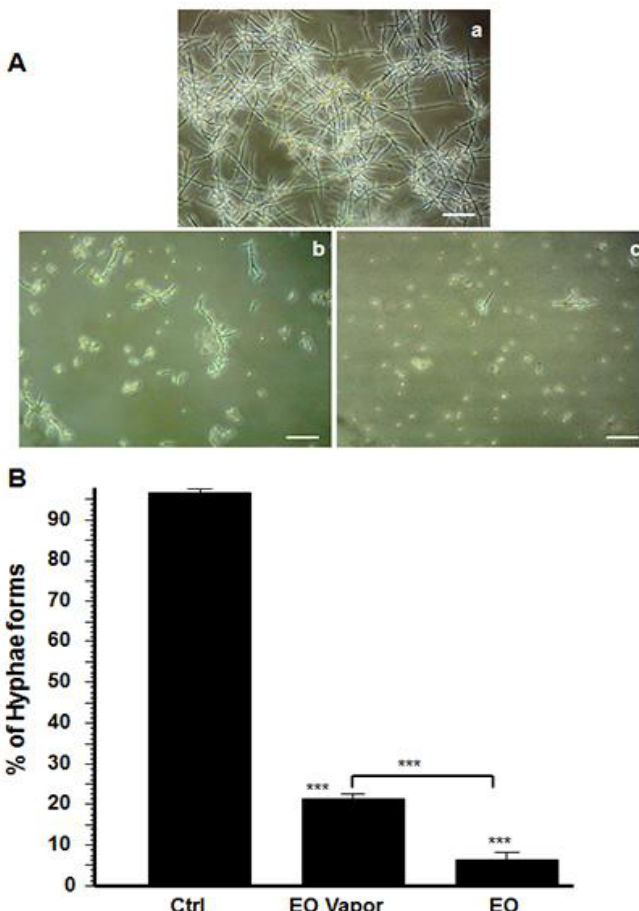
Figure 2. Mentha × piperita essential oil modulated Candida transition from blastospore to hyphal form. C. albicans was cultured with and without 10 µ L/mL of EO or its vapor for 6 h at 37 ◦ C in Sabouraud supplemented medium with 10% fetal calf serum to promote C. albicans transition. The cultures were observed under an inverted microscope and photographed. Panel ( A ) shows morphological changes at 6 h. The number of blastospore and hyphal forms were then counted. The percentage of hyphae was obtained by dividing the number of hyphae by the total number of cells (blastospores and hyphae) in each culture. Panel ( B ) shows the means + SD relative values. The levels of significance were obtained by comparing the percentages of blastospore-to-hyphae transition in the presence/absence of EO; *** p < 0.001. ( a ) Untreated C. albicans ; ( b ) treated with 10 µ L/mL of EO vapor; ( c ) treated with 10 µ L/mL of whole EO added to the culture medium. Scale bar = 50 µ m. The free asterisks refer to the statistical difference when comparing EO effects to control. The bars with asterisks showed the comparison of EO vapor to the EO